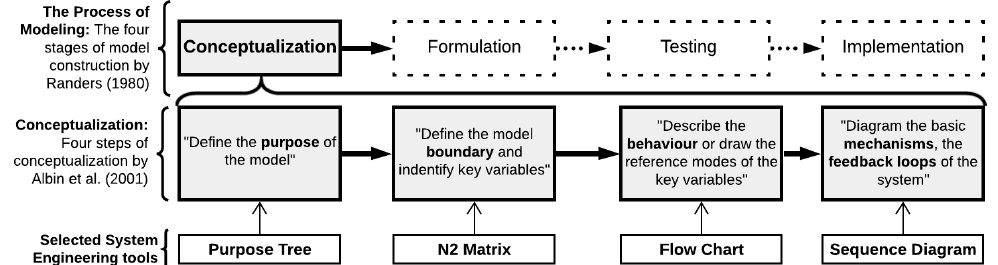
Figure 2. Model conceptualization process defined by Albin [20] and the associated systems engi- neering tools.